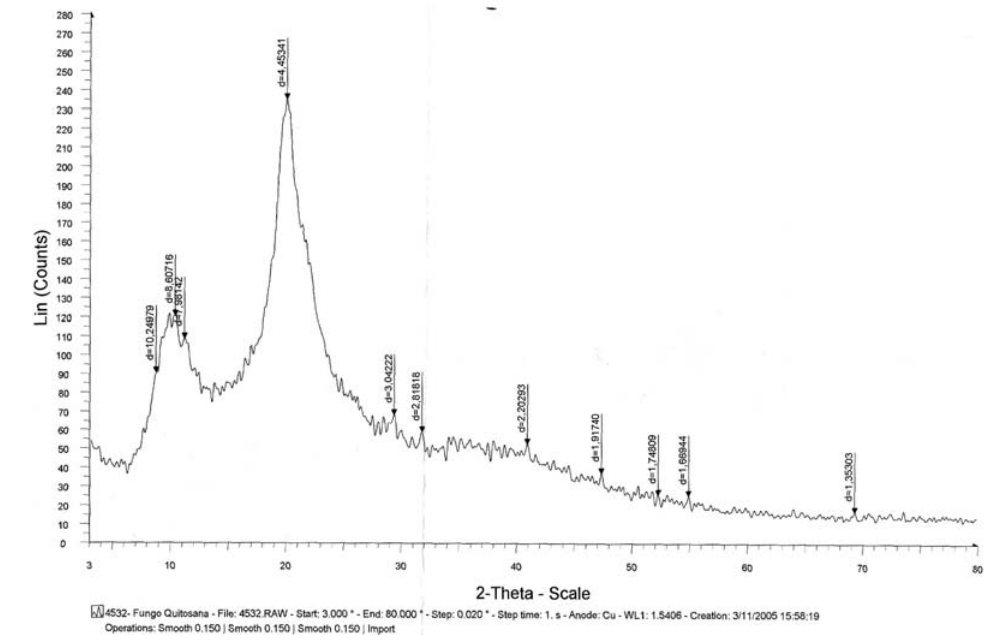
Figure 2. X-ray diffraction of chitosan obtained from Mucor circinelloides (UCP 050)